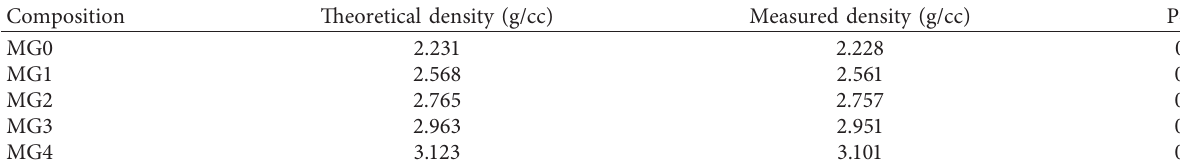
Table 3: Density and porosity values of the samples.